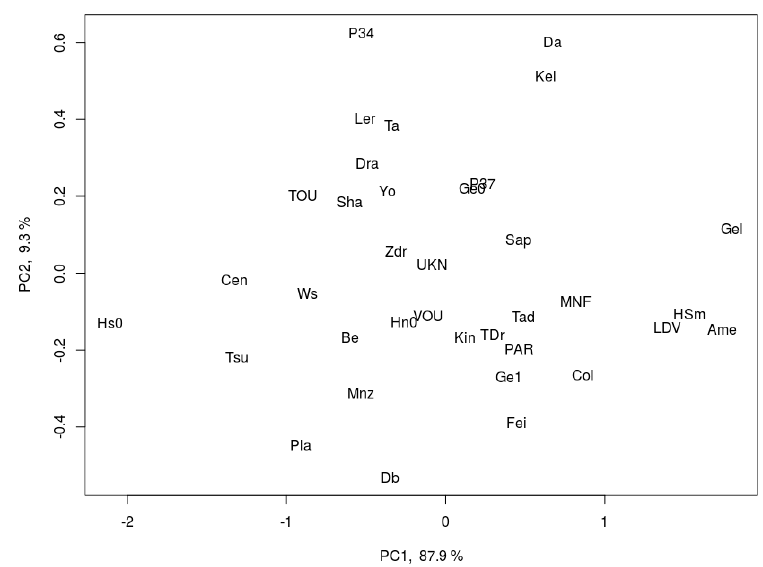
Figure 3. Principal component analysis of 36 Arabidopsis accessions, based on differences in phenotypical response ratio under fluctuating vs. uniform light (log − 2 transformed FL/U ratio). PC1 accounts for 87.9% and PC2 accounts for 9.3% of the total variation.